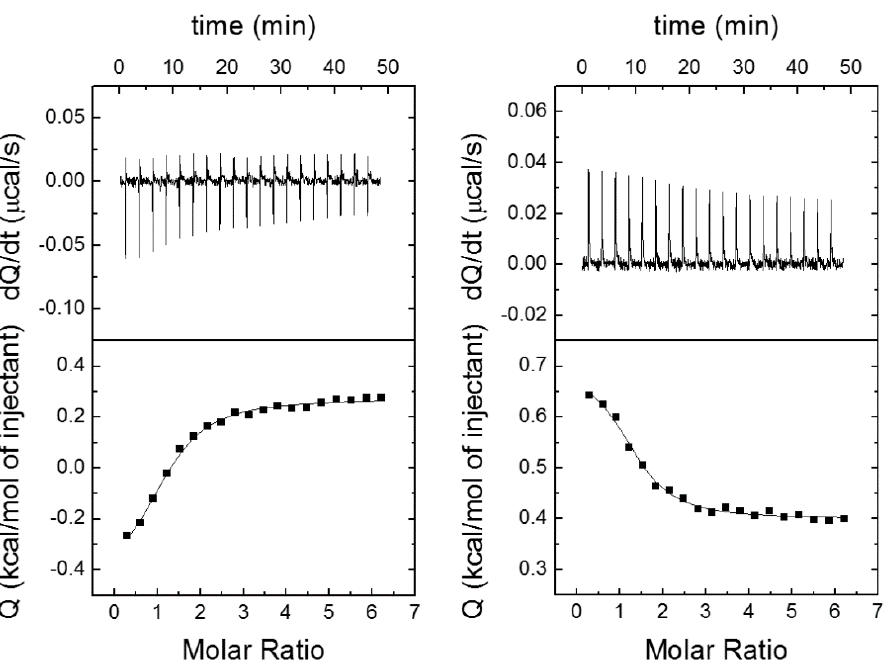
Figure 3. Calorimetric titrations corresponding to the interaction of ZZW-129 (left) and ZZW-142 (right) with NUPR1: Thermograms (thermal power as a function of time) are shown on the top, and binding isotherms (ligand-normalized heat effects as a function of molar ratio) are shown on the bottom. Experiments were performed at 25 °C in sodium phosphate 20 mM, pH 7, 2% DMSO, with 20 µM NUPR1 in the calorimetric cell and 200 µM compound in the titrating syringe, using an Auto-iTC200 instrument (MicroCal-Malvern Panalytical).